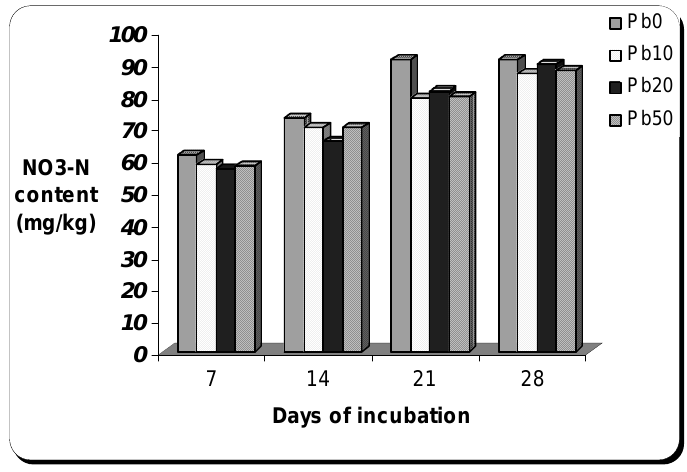
FIGURE 3. Mean effect of different levels of Pb on the changes in NO 3 -N content in soil under 60%